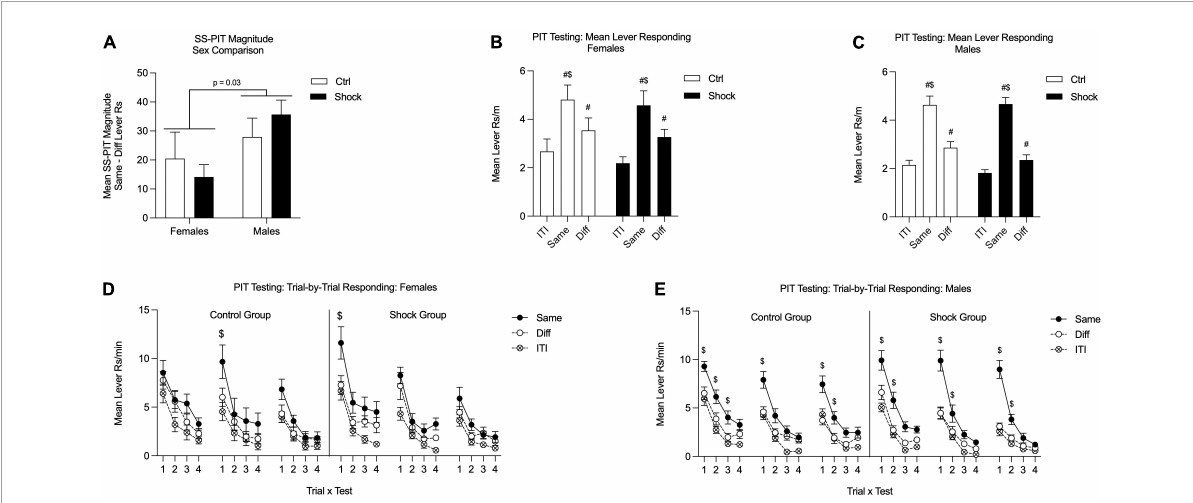
FIGURE6 SS-PIT testing in Ctx B in Experiment 2. (A) SS-PIT magnitudes did not differ between Ctrl and Shock groups, but overall SS-PIT magnitudes were lower in females than males independent of shock treatment. (B) In females, SS-PIT was apparent in that lever responses on the Same lever were greater than responding on the Different lever in both Ctrl and Shock groups. General PIT was also evident in that Different lever responding was also significantly elevated above ITI lever response rates in both groups. (C) In males, SS-PIT was also evident in both the Ctrl and Shock groups with Same lever responses being significantly higher than Different lever responses and as in the females, there was a notable General PIT effect with Different lever response rates being greater than ITI response rates. (D) In females the trial-by-trial SS-PIT effect was not strong and focusing on the first trial of each test it was only evident on 1/3 tests in Ctrl and Shock groups. Overall, response rates began high and extinguished across the trials within each test and SS-PIT was absent in Trial 4 of all 3 tests. (E) In males in both the Ctrl and Shock groups the SS-PIT effect was apparent early in each test and disappeared with repeated trials. This pattern repeated across testing in a spontaneous recovery like effect. In males, SS-PIT was evident on the first trial of every test, but was absent on Trial 4 of every test demonstrating the within-session extinction effect and between-session recovery effect ( $ Same vs. Diff, p < 0.05; # significantly greater than ITI, p < 0.05).